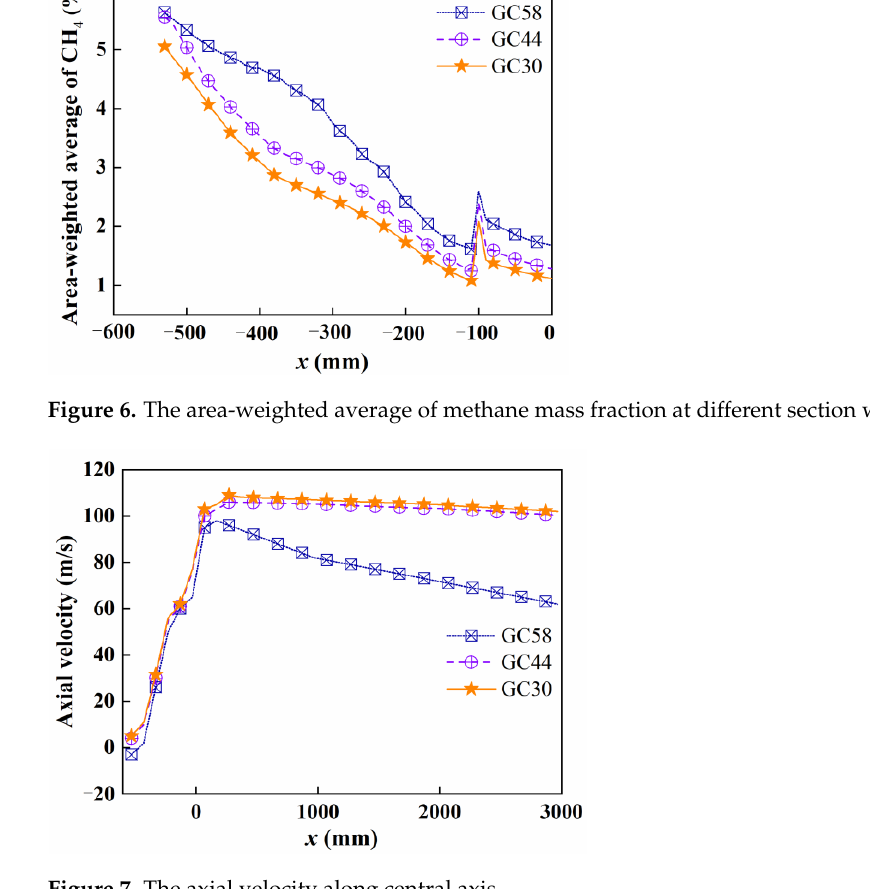
Figure 7. The axial velocity along central axis.